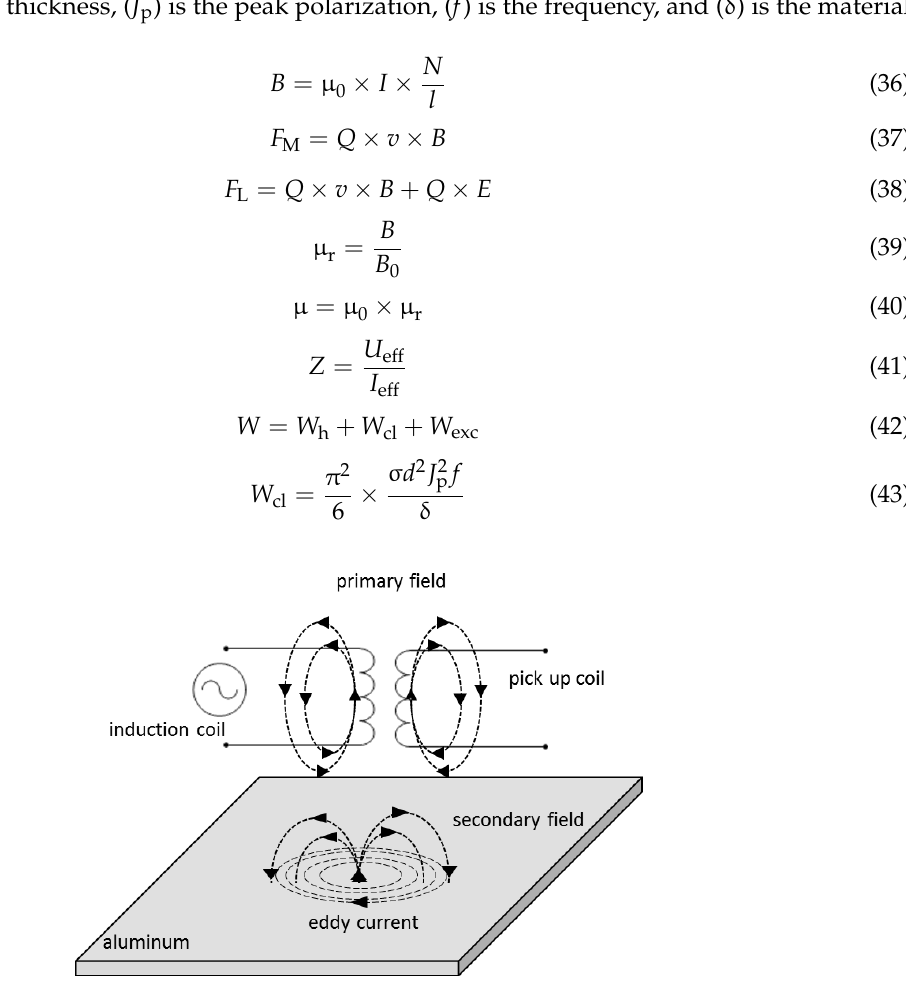
Figure 22. Resonant circuit used of eddy current measurements (adapted from [142]).